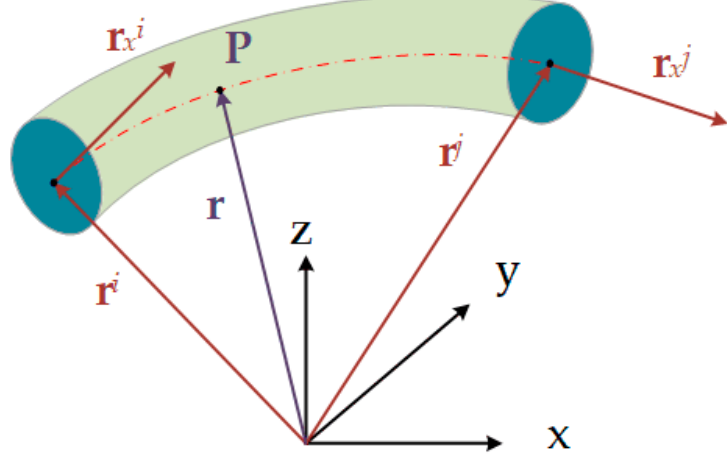
Figure 1. ANCF cable element.